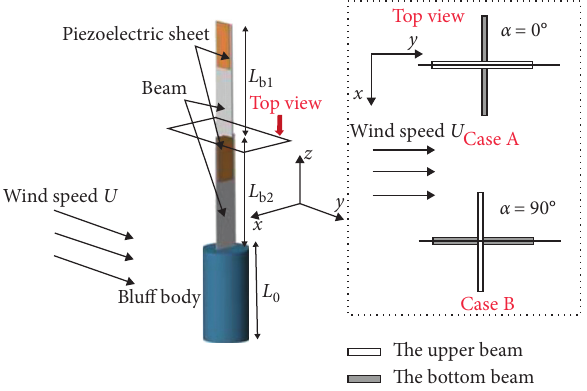
Figure 17: The cross-coupled dual-beam structure [121].